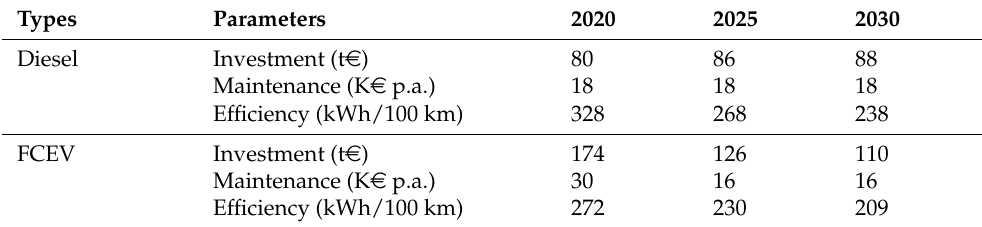
Table A4. Costs and fuel efficiency of diesel trucks and fuel cell electric trucks according to [58].